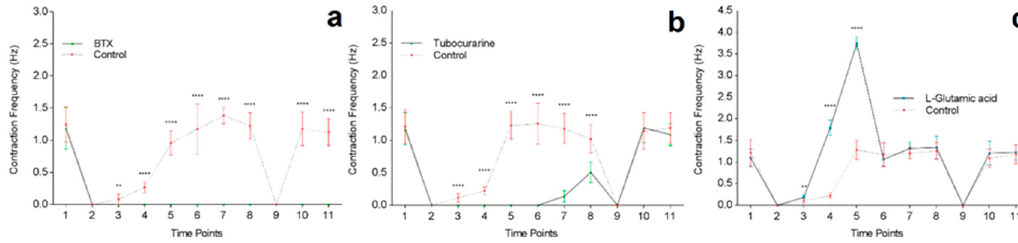
Figure 7. Functional assessment of NMJ formation via the effects of α -bungarotoxin, tubocurarine and L-glutamic acid on myotube contraction frequency at day 14. ( a ) shows the effect of α -bungarotoxin on myotube contraction frequency compared to controls. ( b ) demonstrates tubocurarine effects on myotube contraction frequency compared to controls. ( c ) displays the impact of L-glutamic acid on myotube contraction frequency compared to controls. Data are means ± SD, n = 12, each time point analysed with unpaired T-test, ** p < 0.01, **** p < 0.0001. Time points: (1) -30 s, (2) 0 s, (3) 1 min, (4) 2 min, (5) 5 min, (6) 10 min, (7) 30 min, (8) 1 h, (9) 1 h 1 min (washout), (10) 1 h 30 min, (11) 24 h.